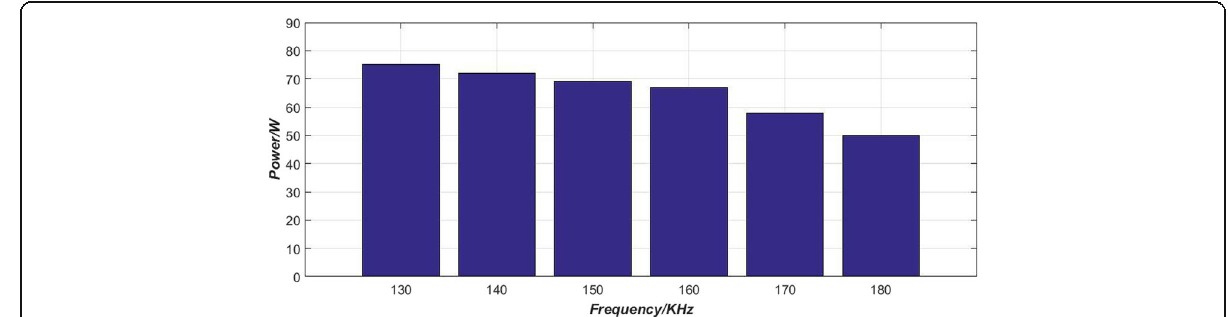
Fig. 13 The maximum output power of the wireless power transfer (WPT) system at different frequencies